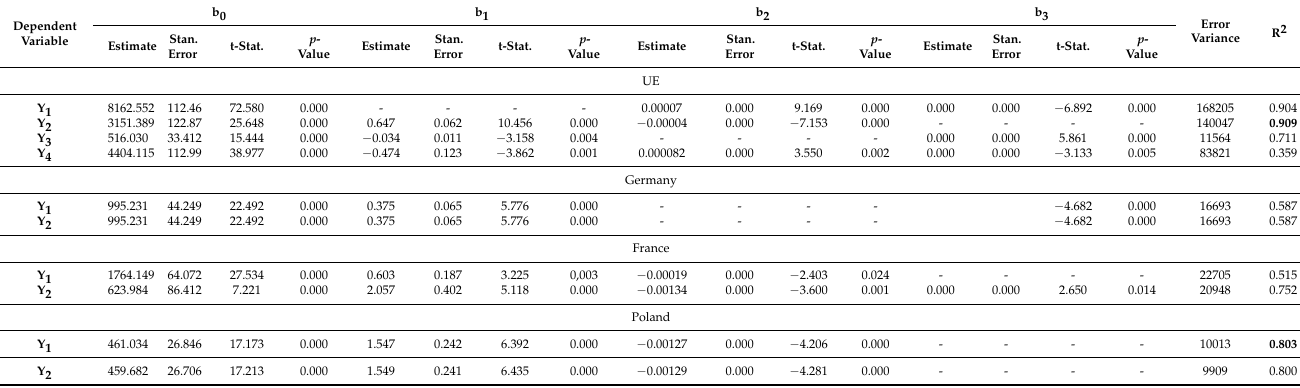
Table 2. Basic statistic relationships between oilseeds (Y 1 ), rape areas (Y 2 ), soybean (Y 3 ), sunflower (Y 4 ), and biodiesel production (x) in UE, Germany, France, and